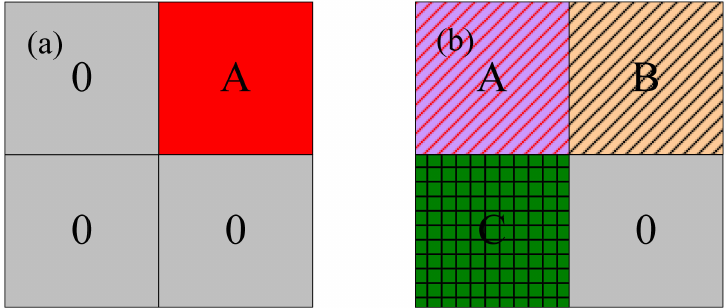
Figure 5. Different pooling areas. ( a ) one Feature mapping; ( b ) other feature